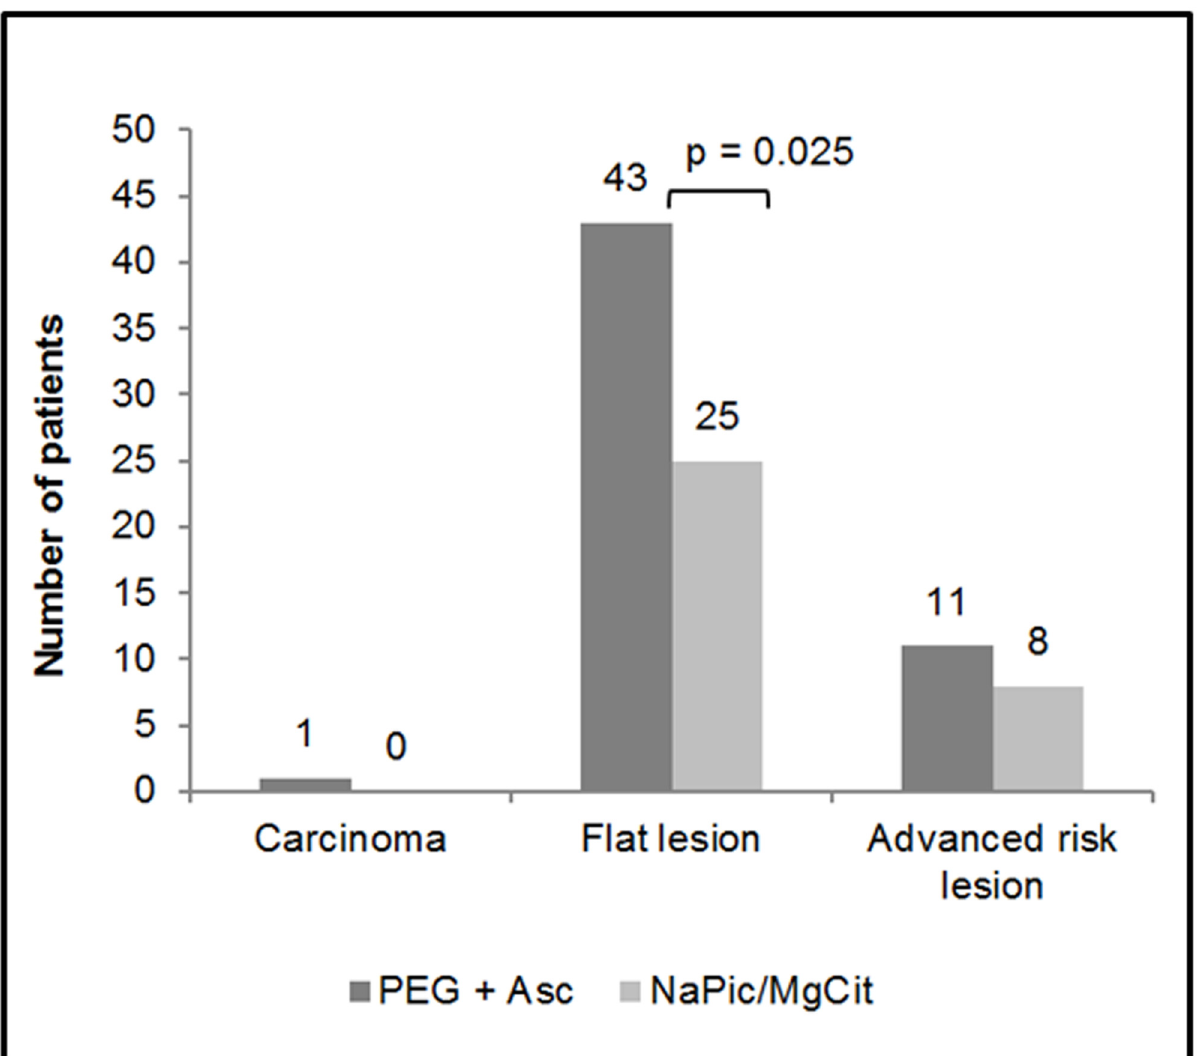
Fig 3. The numbers of patients with at least one carcinoma, flat lesion or advanced risk lesion (ITT population). Statistical significance was determined by two-sided Chi-square tests. Data are missing for one patient in the PEG+Asc treatment group. NaPic/MgCit, sodium picosulfate/magnesium citrate; PEG+Asc, polyethylene glycol plus